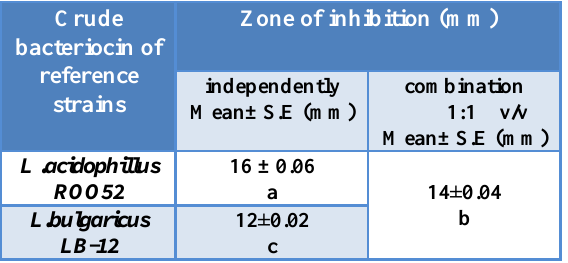
Different letters in columns revealed significant differences (P ˂0.05) between the diameters of the inhibition zone.SE = Standard